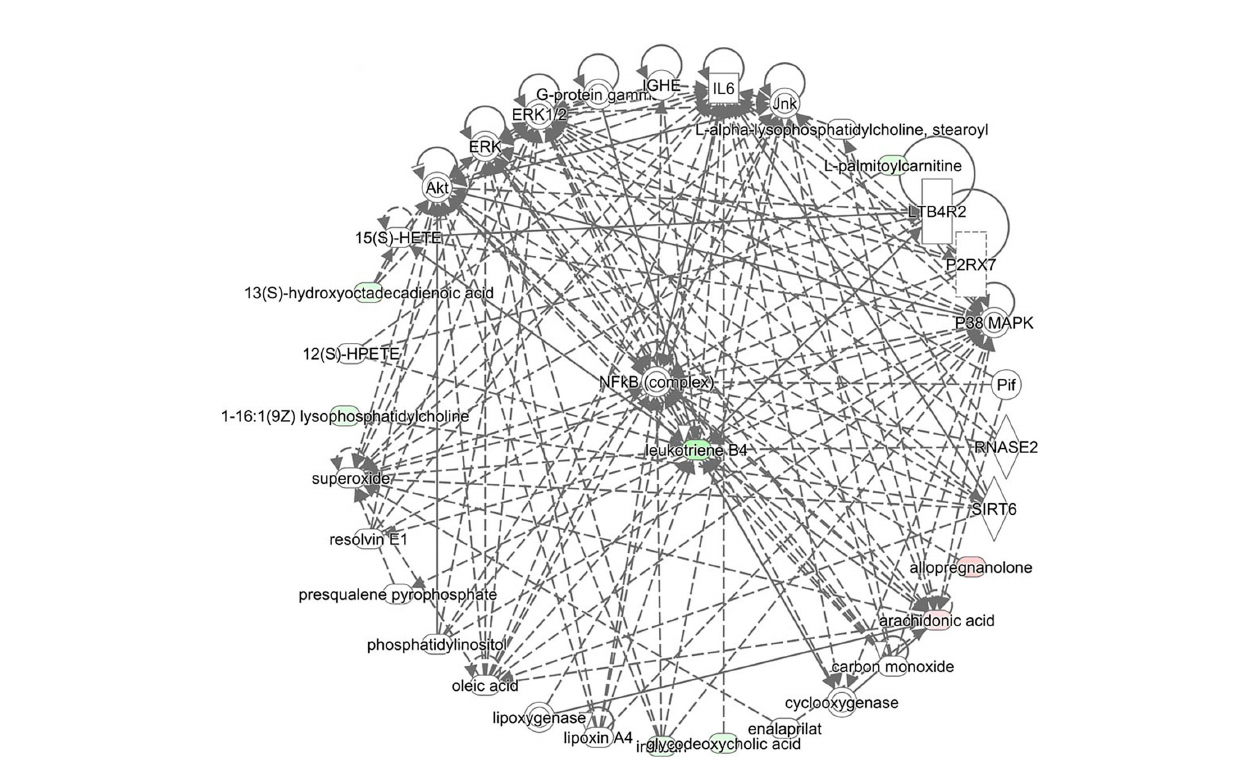
FIGURE 6 | Biomarker metabolites network based on intelligent pathway analysis use IPA analysis. Light green represents low expression in diseases, light pink represents high expression in diseases, and the darker the color, the greater the